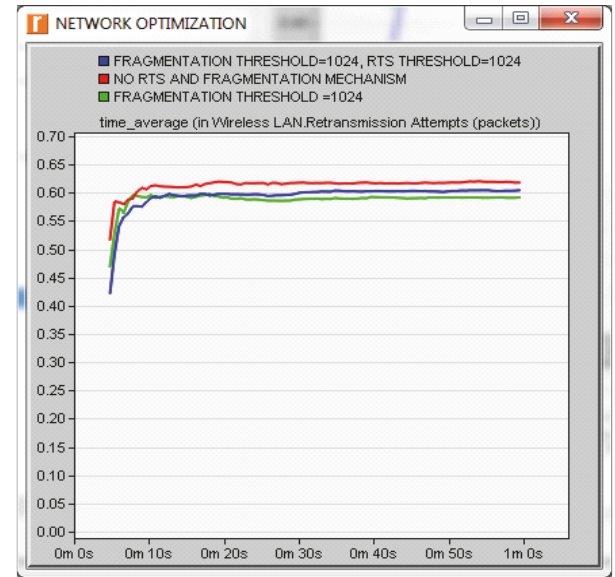
Figure 18: WLAN optimization with RTS and fragmentation mechanisms.